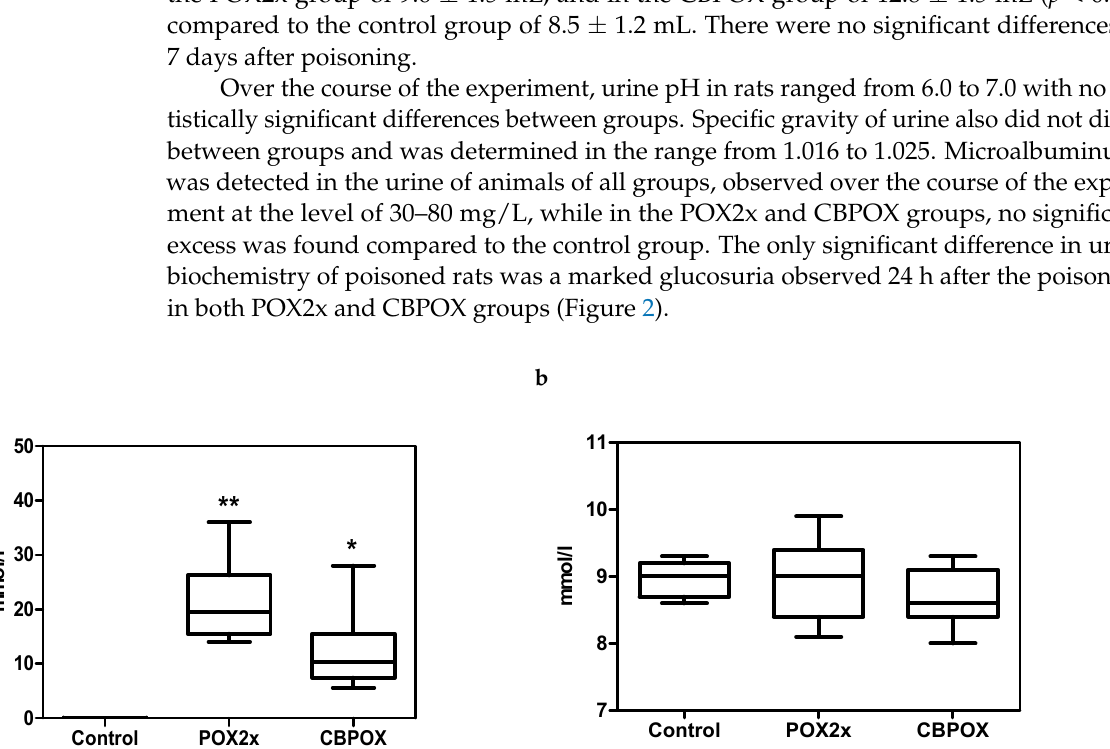
Figure 1. Endogenous creatinine clearance in rats: ( a ) 1 day, ( b ) 3 days, and ( c ) 7 days after the poisoning; ** p < 0.01 compared to Control group.